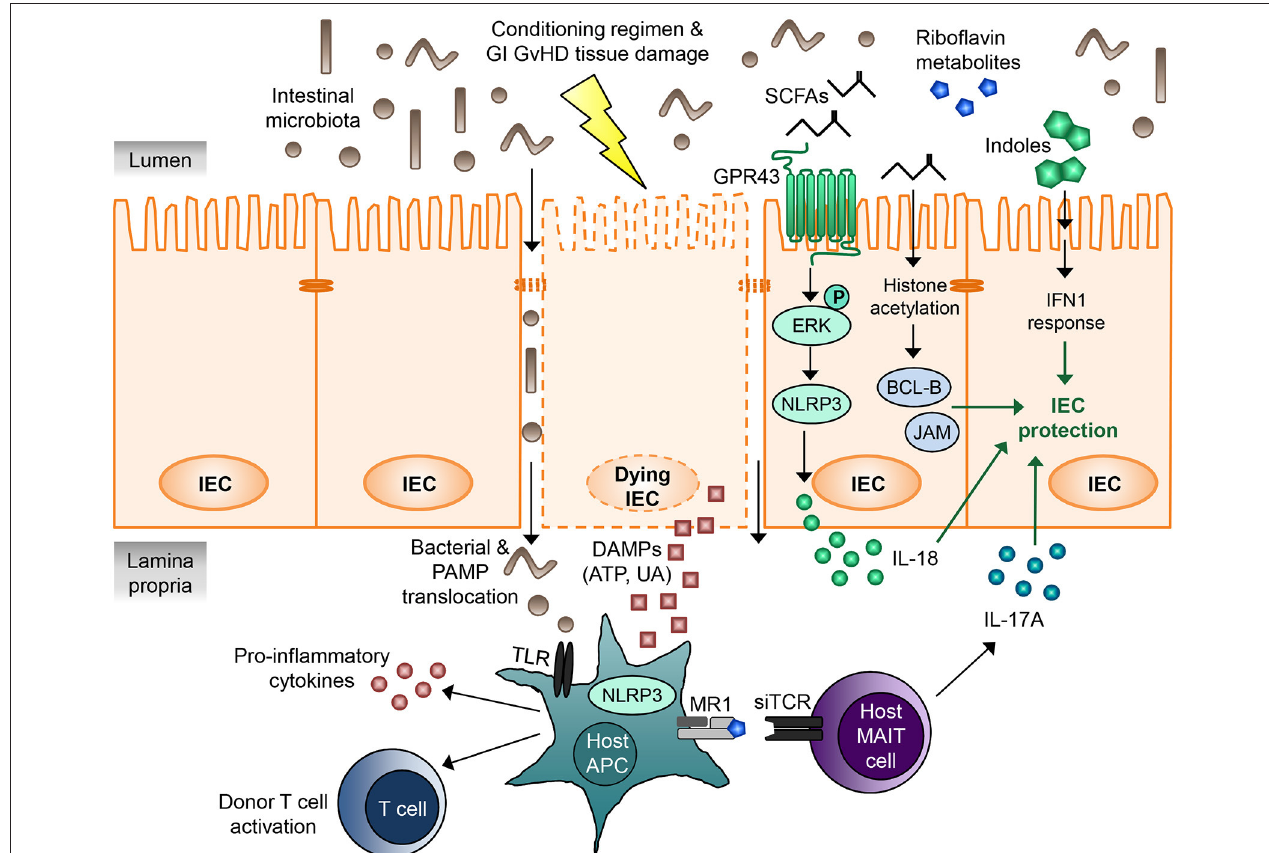
FIGURE 1 | Microbial metabolites regulating gastrointestinal GVHD. IECs are damaged by the cytotoxic conditioning regimen as well as by GI GVHD, leading to disruption of the intestinal barrier. DAMPs released by the dying IECs as well as translocating bacteria and PAMPs activate host APCs via TLRs and the NLRP3 inflammasome, resulting in pro-inflammatory cytokine release, donor T cell activation, and GVHD. Microbial metabolites derived from intestinal microbiota can regulate IEC damage and mitigate GVHD. SCFAs mediate IEC protection via at least two different mechanisms. Firstly, binding of SCFAs to the G-protein-coupled receptor GPR43 on IECs leads to ERK phosphorylation and subsequent NLRP3 inflammasome activation, which promotes IEC integrity and repair by increasing IL-18 secretion. Secondly, the SCFA butyrate acts as a histone deacetylase inhibitor, thereby increasing expression of many different target genes, including anti-apoptotic BCL-B and the junctional protein JAM. This results in decreased IEC apoptosis and increased junctional integrity and hence IEC protection. MAIT cells located in the lamina propria respond to riboflavin metabolite antigens presented on the MHC class I-like molecule MR-1 to secrete large amounts of IL-17A, which enhances intestinal barrier integrity. Indoles and indole derivatives act via type I IFN signaling to protect and repair the mucosal barrier from damage and ameliorate GVHD. The exact molecular mechanisms and involved proteins remain to be elucidated. APC, antigen-presenting cell; DAMP, danger-associated molecular pattern; GI, gastrointestinal; GVHD, graft-vs.-host disease; IEC, intestinal epithelial cell; IFN, interferon; JAM, junctional adhesion molecule; MAIT cell, mucosal-associated invariant T cell; PAMP, pathogen-associated molecular pattern; SCFA, short chain fatty acid; siTCR, semiinvariant T cell receptor; TLR, Toll-like receptor; UA, uric acid.